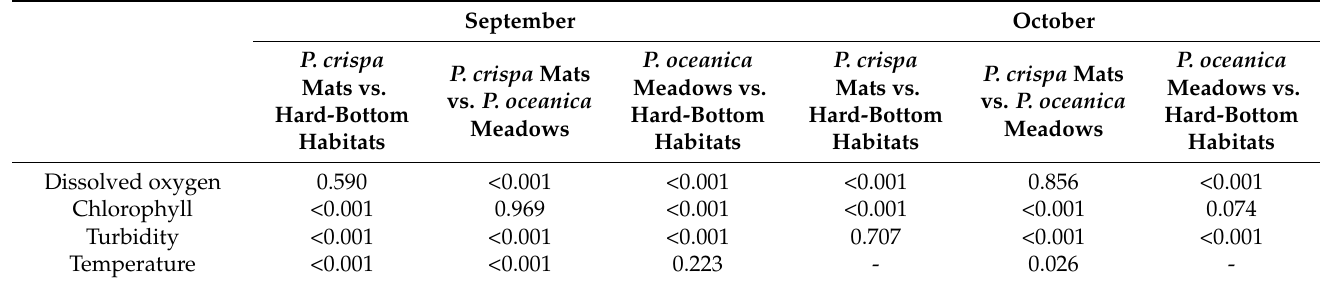
Table 2. Post hoc Tukey HSD statistical analysis to evaluate differences between pairs of environments ( Phyllophora crispa mats, Posidonia oceanica meadows, hard-bottom habitats) on the monthly values of environmental